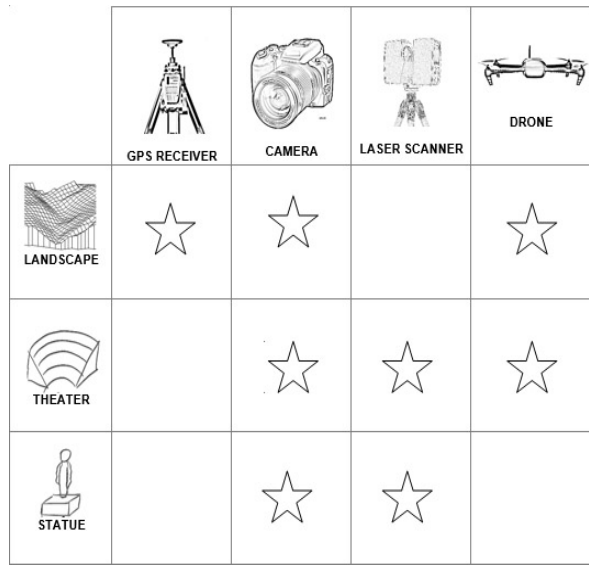
Figure 10. Different instruments suitable for survey of each element of